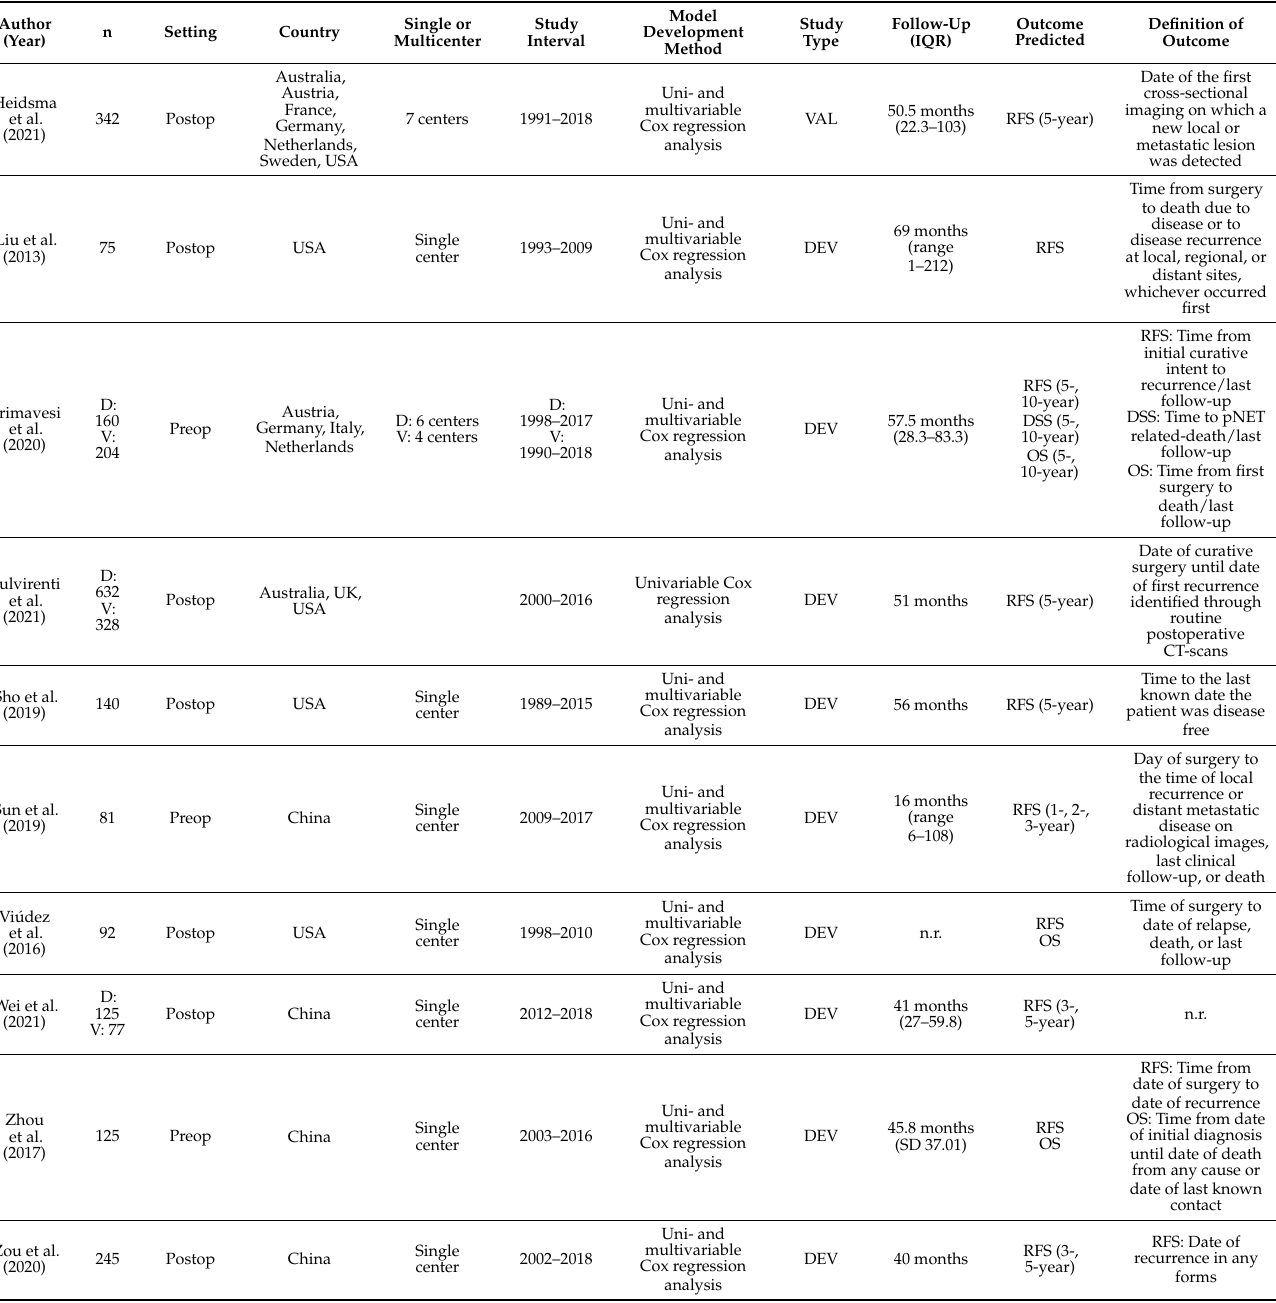
RFS: Time from date of surgery to date of recurrence OS: Time from date of initial diagnosis until date of death from any cause or date of last known contact RFS: Date of recurrence in